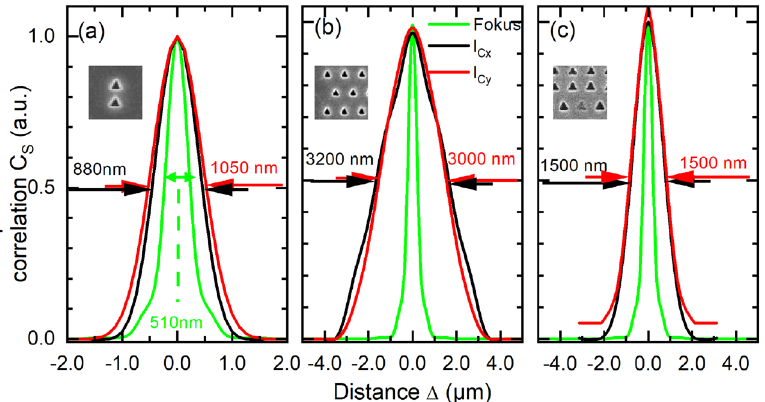
Figure4: (a – c)Spatialautocorrelationtrace C s ( Δ )alongthe x -(black)andthe y -direction(red)forthemostdominanthotspotofeachsample, indicated by the black/red-dotted crosses in Figure 3. The green line represents the spatial resolution of the second harmonic (SH) micro- scope. For the dimer structure in (a), the spatial autocorrelation length l c , x along the x -axis is smaller than l c , y , re fl ecting the extension of the triangular dimer structure along the y -axis. (b) + (c) The measured autocorrelation length increases to 3200 nm for the x -direction and to 3000 nm for the y -direction for the array of hexagonal pattern (b) and decreases again to 1500 nm for both the x - and y -axes for the stitched array in (c). The trace for the y -axis in (c) is slightly shifted for better